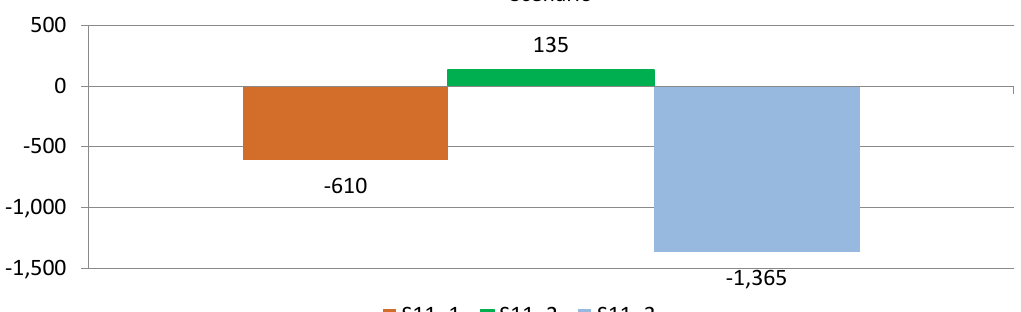
Figure 9. NPV if available maximum ESS power capacity is 1 MW, and ESS belongs to the energy company and is cofunded by EU grant.